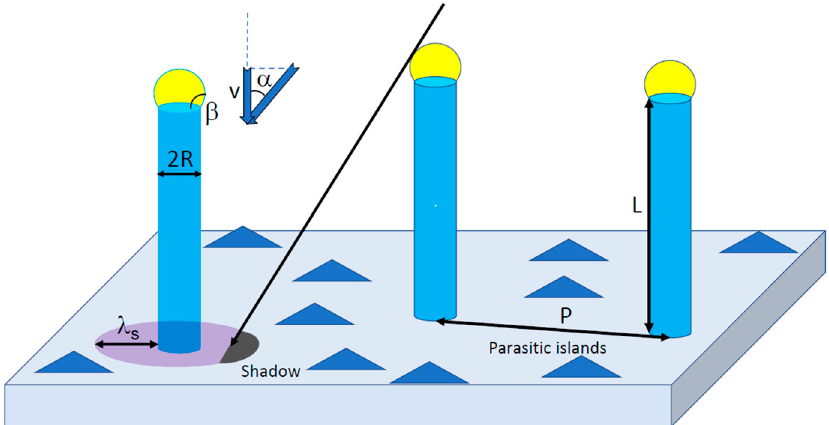
Figure 1. Ensemble of identical VLS NWs with length L and radius R . The contact angle of the catalyst droplets on the NW tops equals β . The molecular beam of an element which limits the NW growth is inclined at an angle α with respect to the substrate normal; v is the 2D equivalent growth rate. The NWs are fed from the collection rings of width λ s on the substrate surface around each NW. Distance between the NWs (pitch) equals P . Parasitic growth of islands or the quasi-2D layer occurs between the NWs outside the collection rings. The shadowing effect originates from the neighboring NWs which block a fraction of the collection rings.